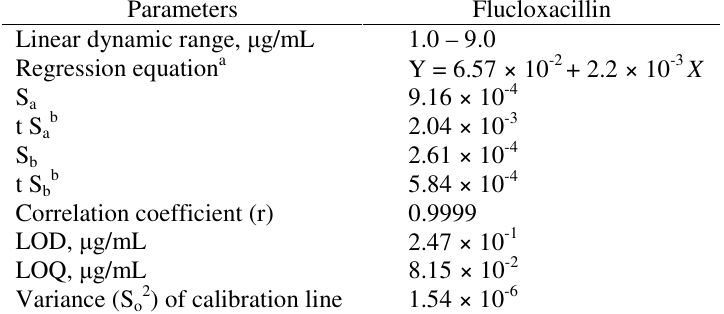
Figure 4. Linear regression equation of the proposed method. Table 1. Summary of optical and regression characteristics of the proposed